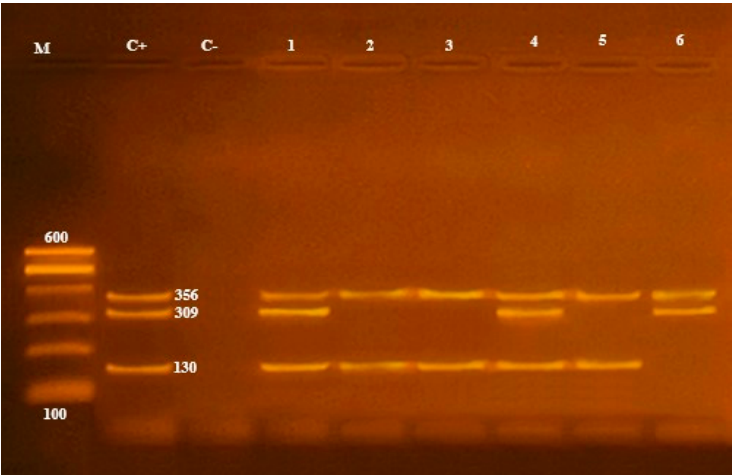
Figure 4. 16S rRNA (356 bp), aerA (309 bp) and ahhl (130 bp) virulence genes to characterize A. hydrophila . Lane M: 100 bp ladder, Lane C+: control positive, Lane C-: control negative; Lanes 1, 2, 3, 4, 5 and 6: positive strains for 16S rRNA genes; Lanes 1, 4 and 6: positive strains for aerA genes; Lanes 1, 2, 3, 4 and 5: positive strains for ahhl genes.